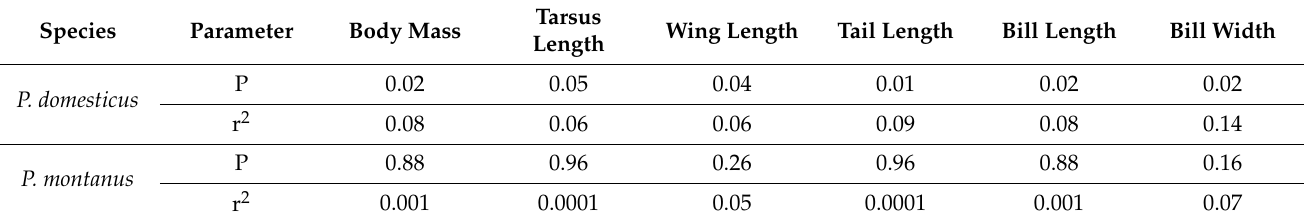
Table 1. Relationship between morphological measurements of sparrows and elevation.